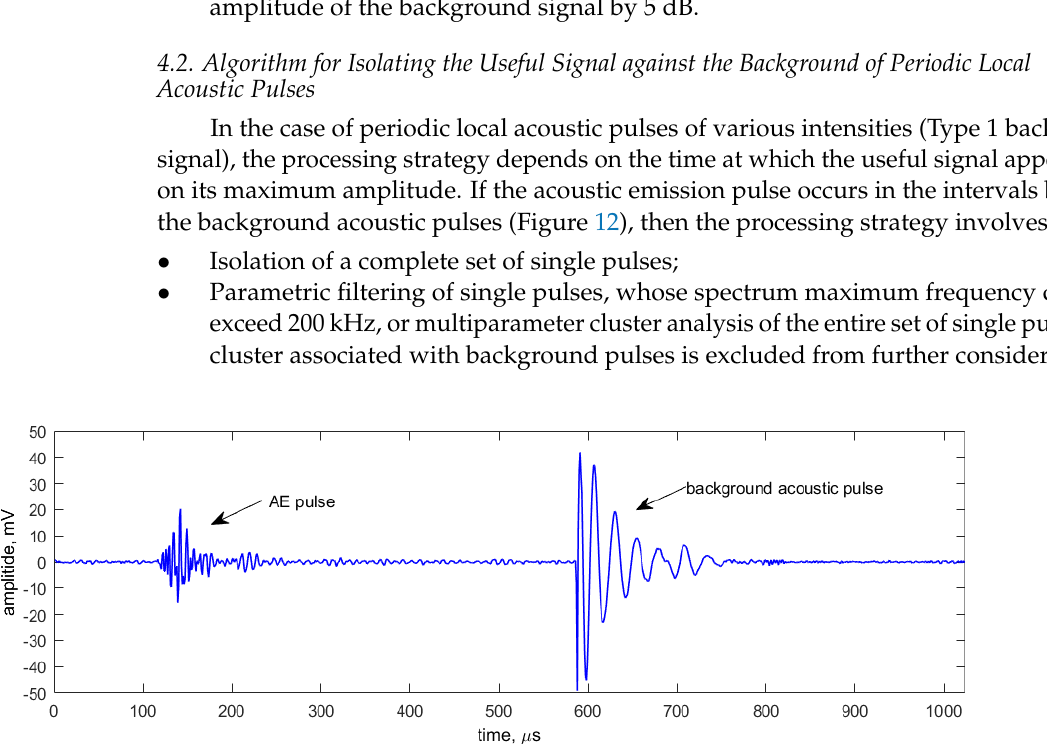
Figure 12. Example of the signal with a sequential arrangement of an AE pulse and a background acoustic